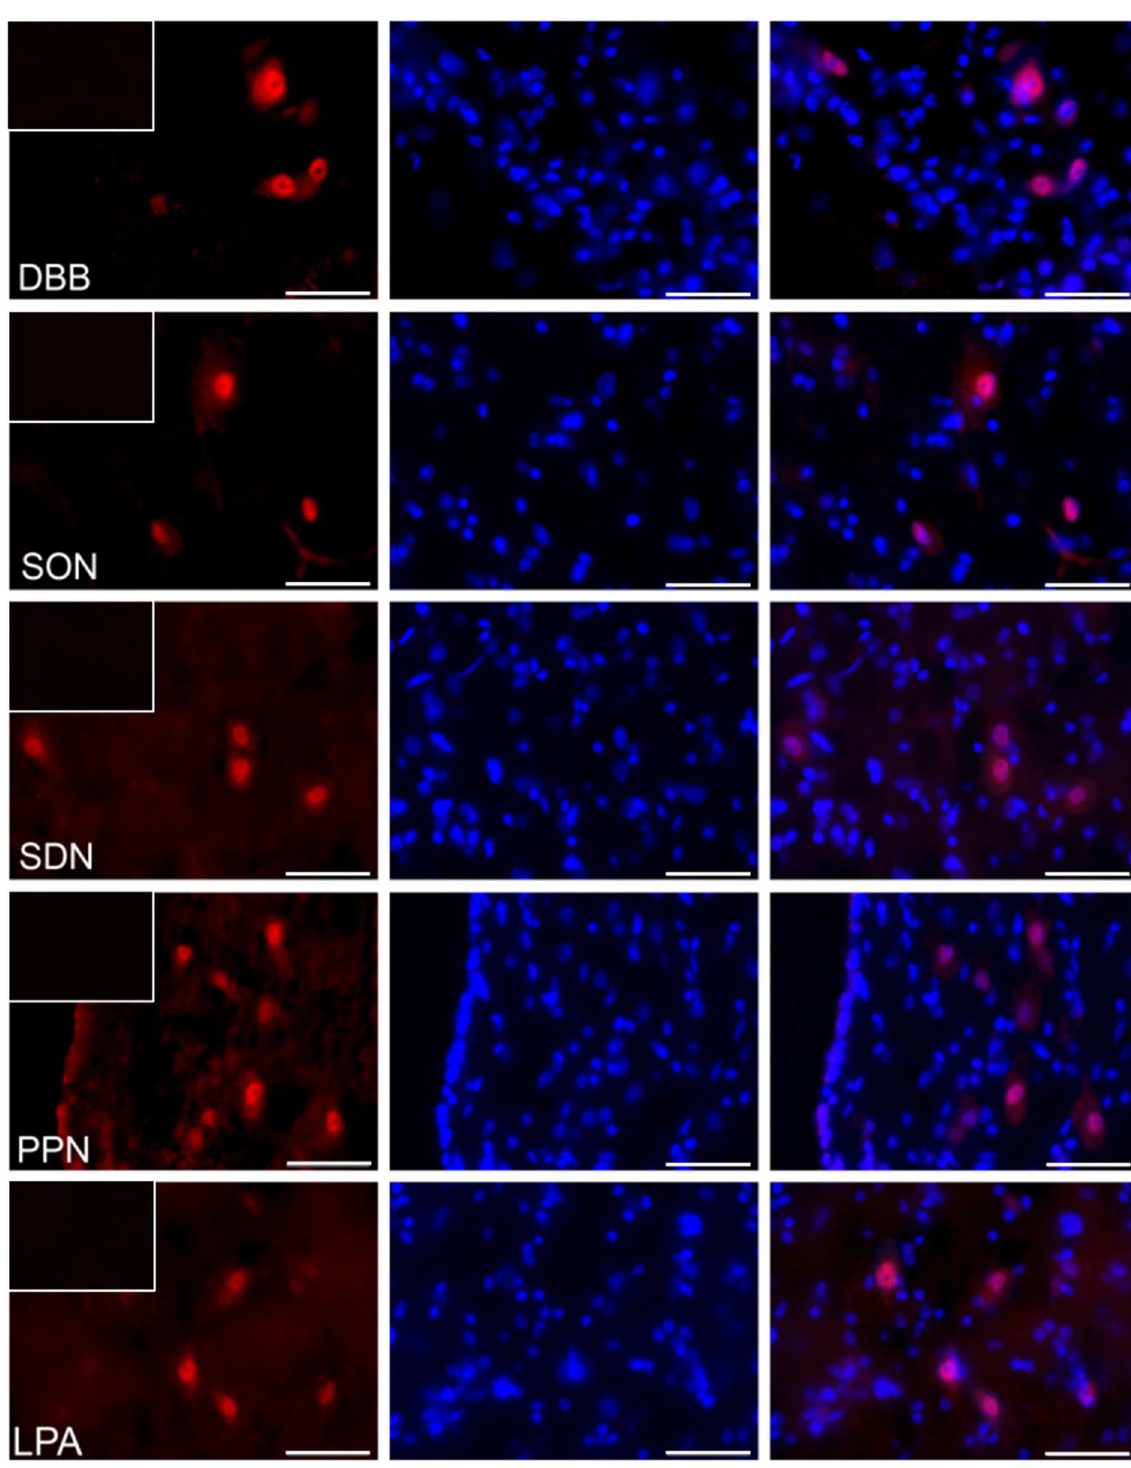
Figure 2. The visfatin localization in the porcine hypothalamus on days 15–16 of early pregnancy. Immunoreactivity of visfatin was determined by fluorescent immunohistochemistry. Columns from left: first—visfatin expression, visualized by Alexa Fluor 555 as red fluorescence; second—nuclei stained with DAPI, visualized as blue fluorescence; third—merged images of channels (Olympus BX51, Olympus Soft Imaging Solutions, Germany). In the upper left corner of each image in the first column—negative control, where the primary antibody were replaced with non-immunosera. Particular images indicate the immunolocalization of visfatin in the diagonal band of Broca (DBB), supraoptic nucleus (SON), preoptic area (SDN), periventricular nucleus (PPN), lateral (LPA) and medial preoptic area (MPA), paraventricular nucleus (PVN), suprachiasmatic nucleus (SCN), arcuate nucleus (ARC), as well as ventromedial nucleus (VMH). Immunofluorescent staining was repeated on three pigs. Scale bar: 50